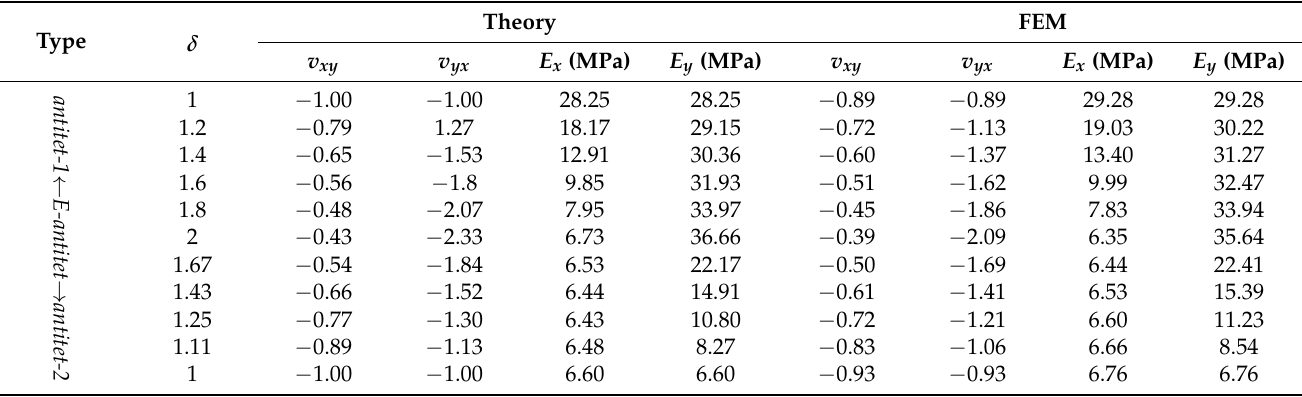
Table A2. Detailed results of Poisson’s ratio and Young’s modulus of E-antitet at different δ .